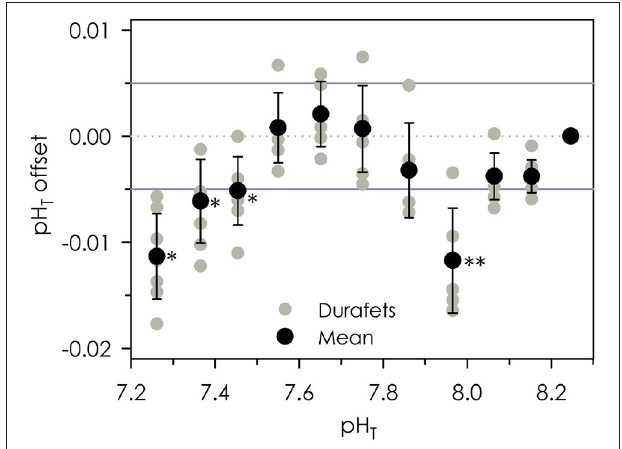
FIGURE 3 | Mean and individual offsets of eight Durafet pH observations compared to reference pH samples analyzed via the spectrophotometric method. Solid reference lines indicate a ± 0.005 units pH T error associated with replicate spectrophotometric measurements. *Indicates sampling near the lower pH limit of m -cresol purple. **Indicates sampling that occurred during the fastest observed temperature change.